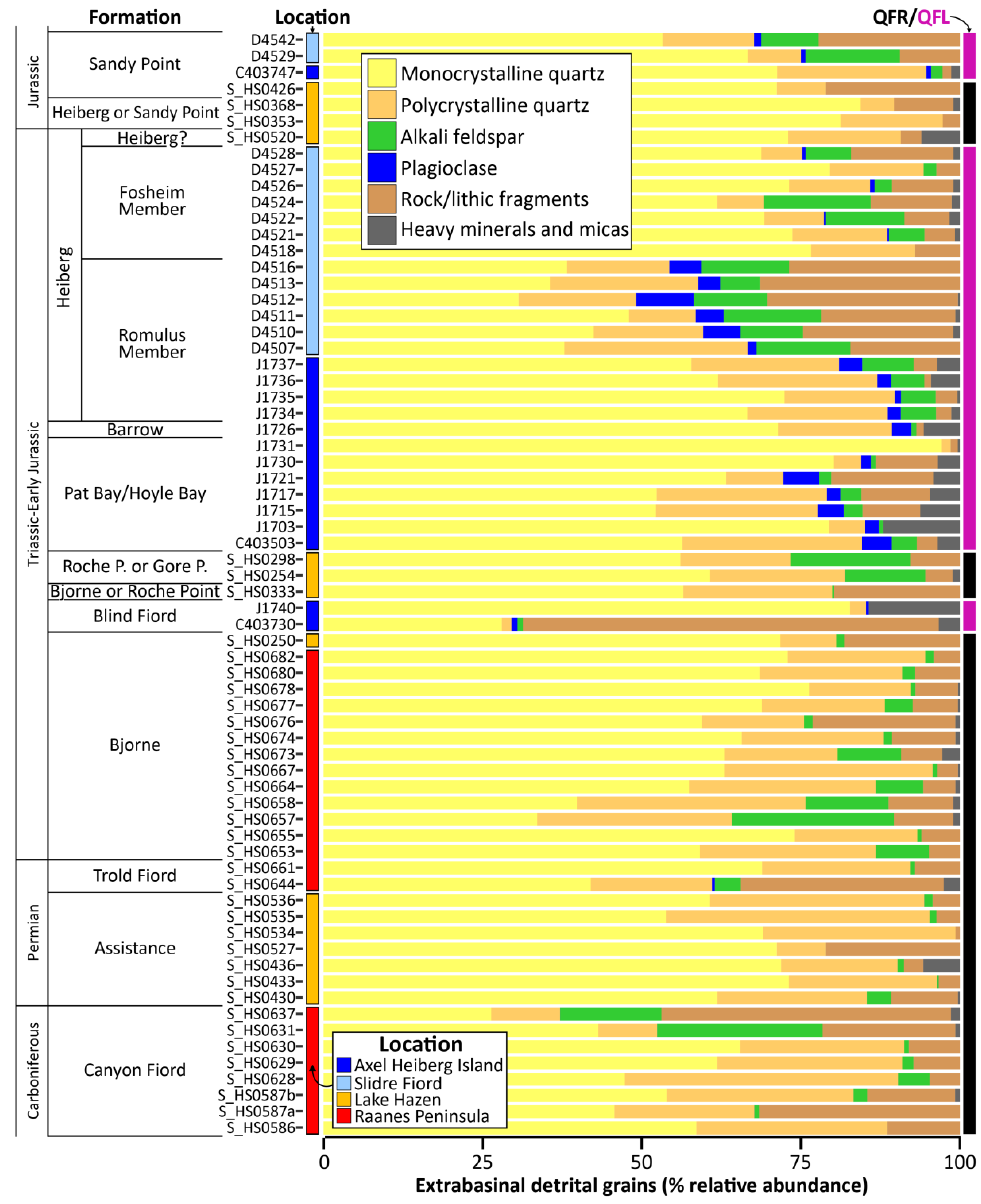
Figure 4. Summary bar charts of the petrographic point-count data. QFR = quartz, feldspar and rock fragments (traditional/Indiana method data); QFL = quartz, feldspar and lithic fragments (Gazzi-Dickinson method data).